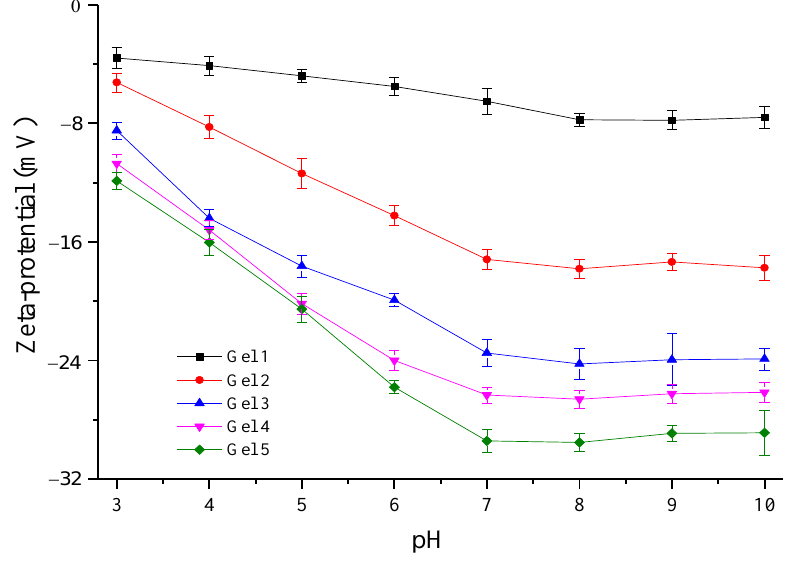
Figure 4. Zeta-potential of hydrogels at different pHs.